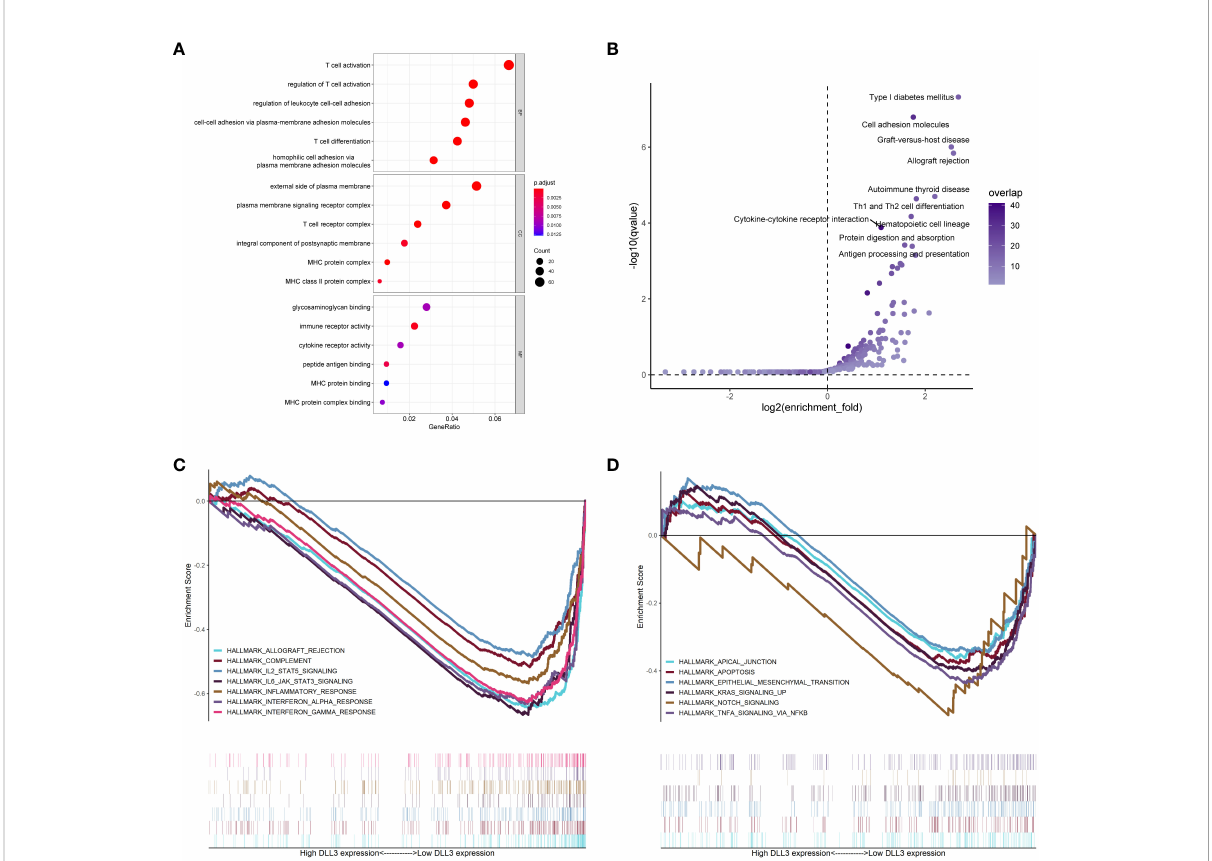
FIGURE 4 Functional annotation of DLL3 in UM. (A, B) GO (A) and KEGG (B) enrichment analyses of the DEGs based on DLL3 expression. BP, biological process; CC, cellular component; MF, molecular function. (C, D) GSEA was applied to explore the regulatory mechanisms of DLL3 in UM with the hallmarks of cancer set as the reference gene